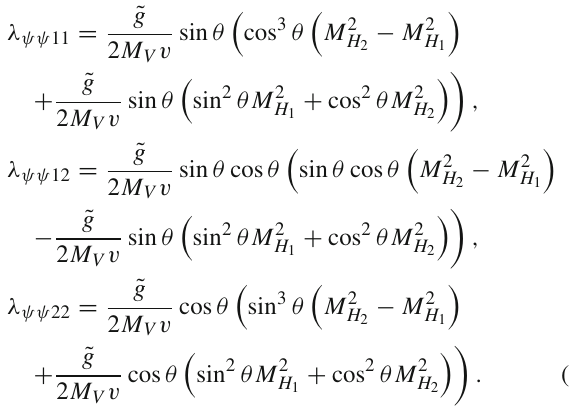
Table 1 Z 2 × Z (cid:15) assignments of the various fields of the SU(3) dark 2 model Gauge